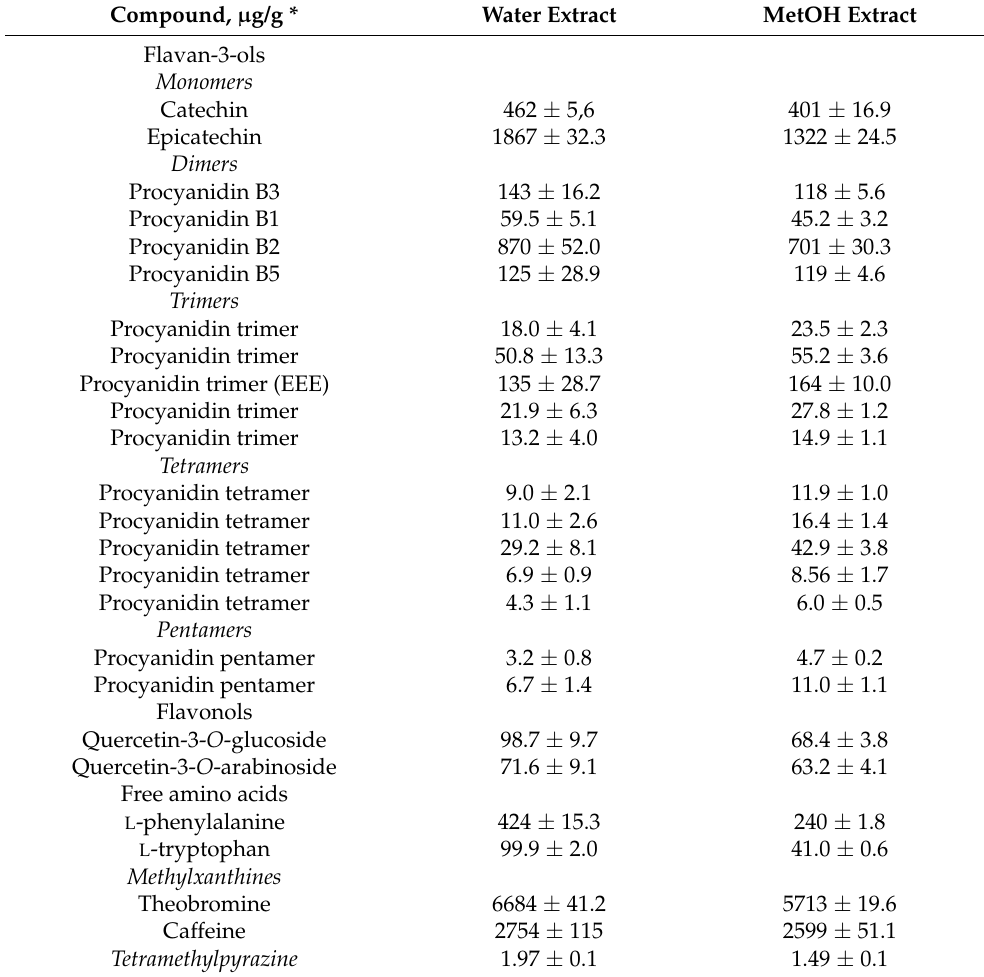
Table 2. Composition of the cocoa powder extracted with water or methanol:water